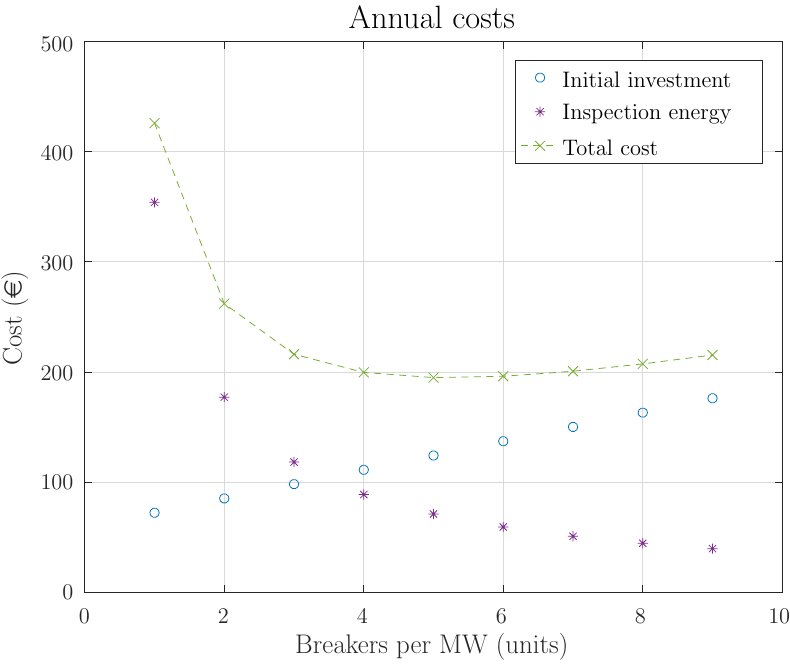
Figure 13. Annual prorated costs resulting from the EL maintenance application for installed MWp for the selected use case.